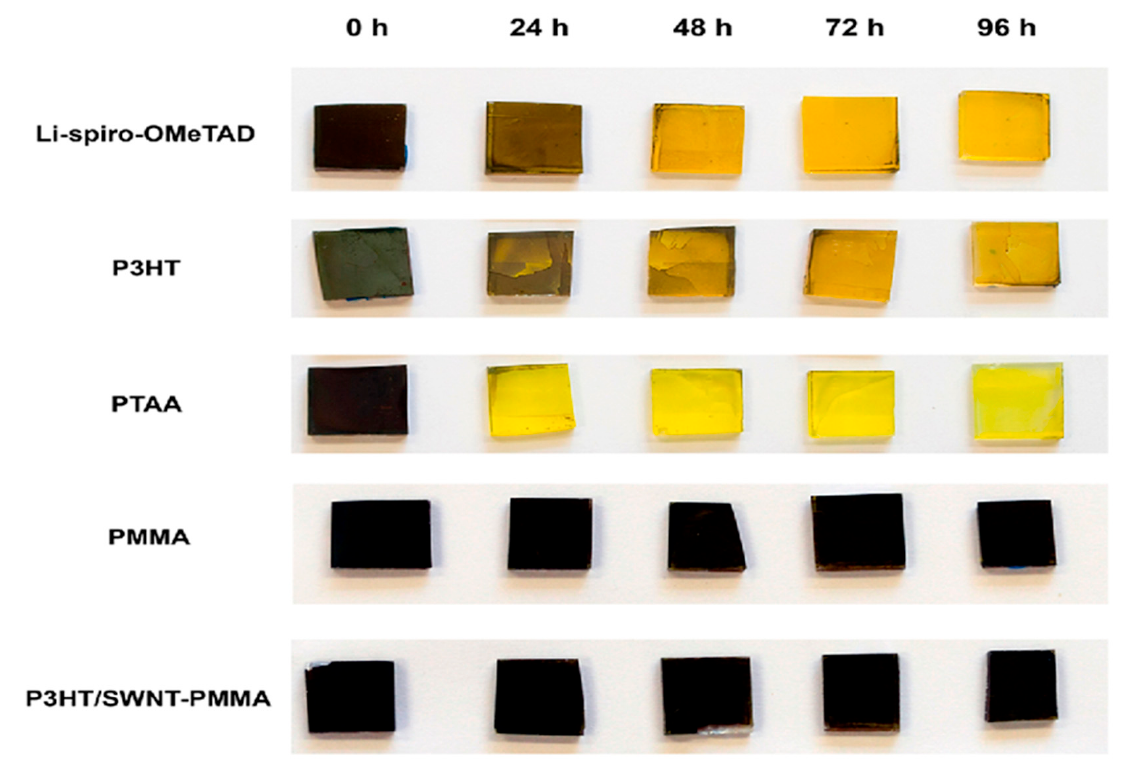
Figure 3. Photographs illustrating the visible degradation of the perovskite layer with different hole transport layers exposed to 80 °C under ambient conditions. The conversion from the dark initial color to yellow indicates the degradation of the perovskite material to lead iodide. Over 96 h of heat exposure, only a composite structure of carbon nanotubes and PMMA was able to prevent degradation. Reprinted with permission from Ref. [114]. Copyright: American Chemical Society 2014.